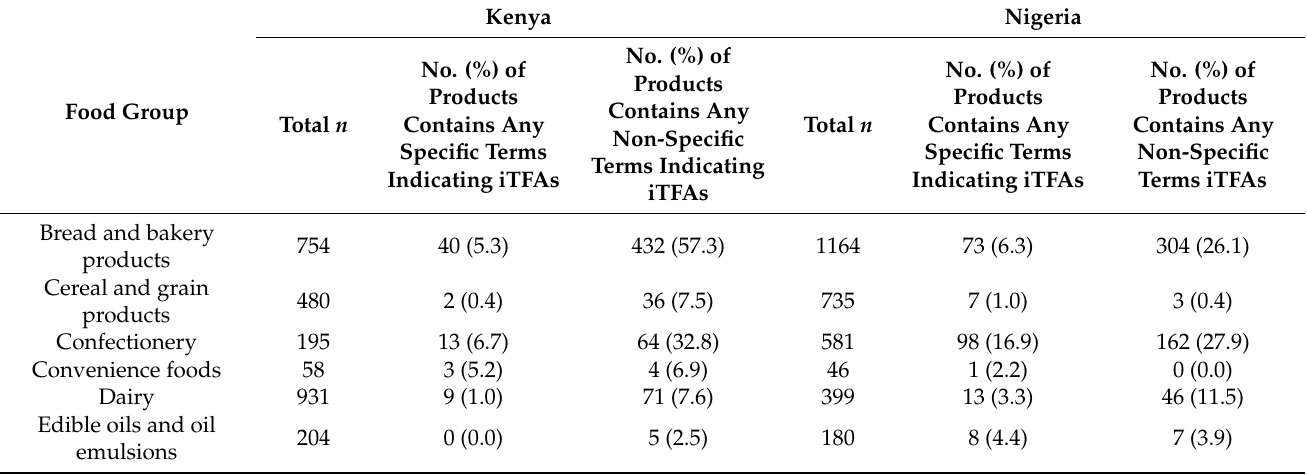
Table 1. Presence of iTFA-indicative ingredients in pre-packaged foods in Kenya and